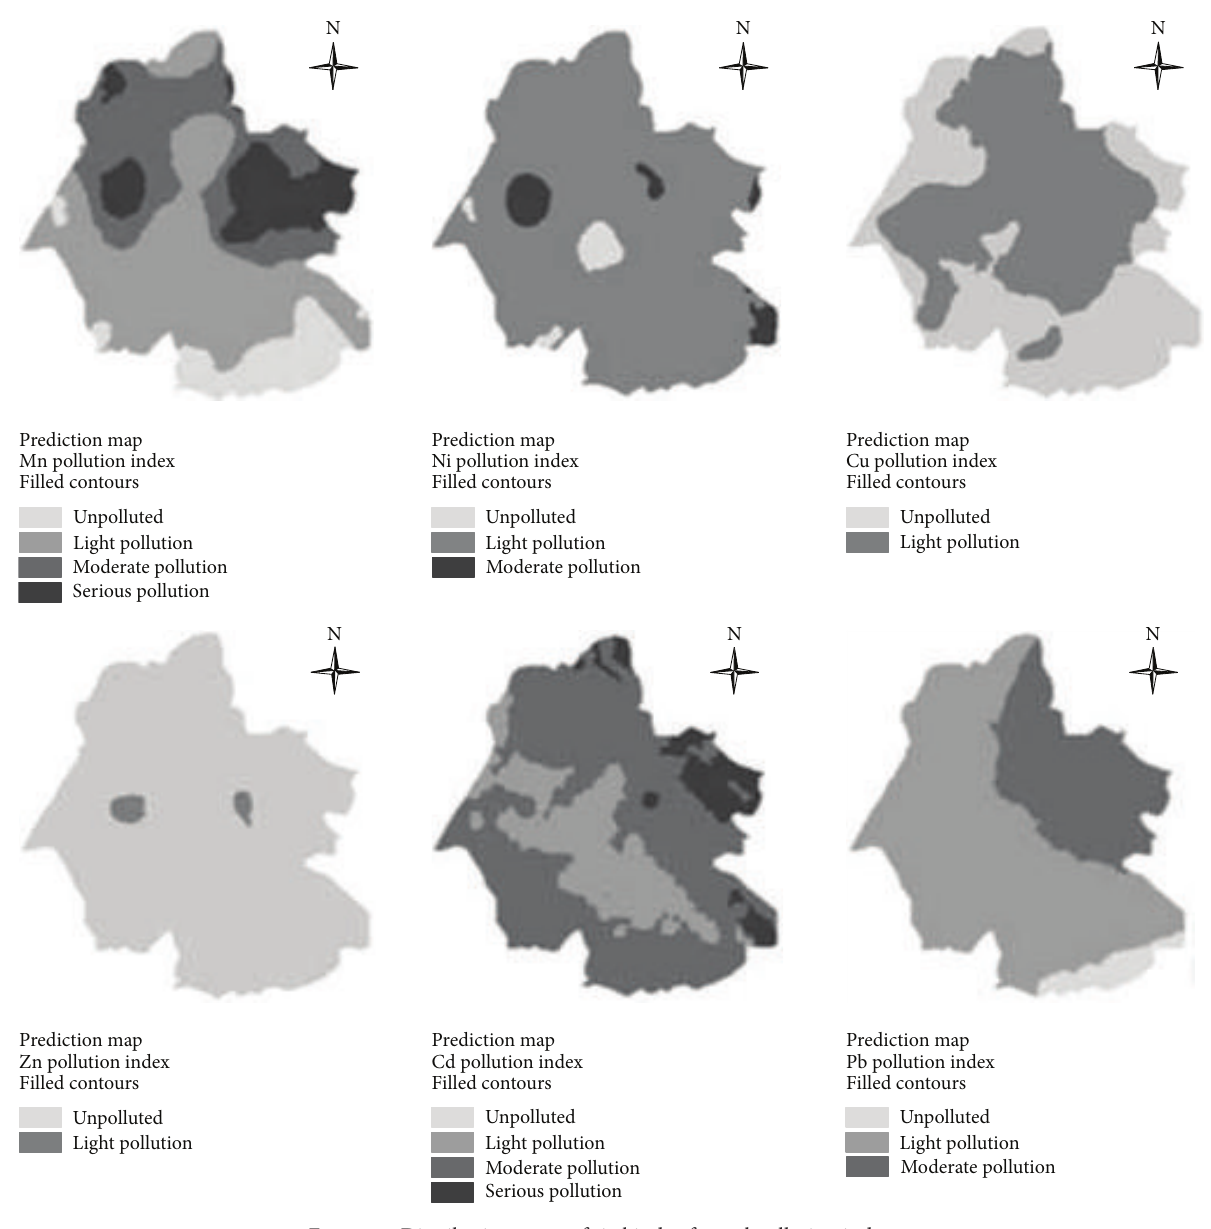
Figure 5: Distribution maps of six kinds of metal pollution